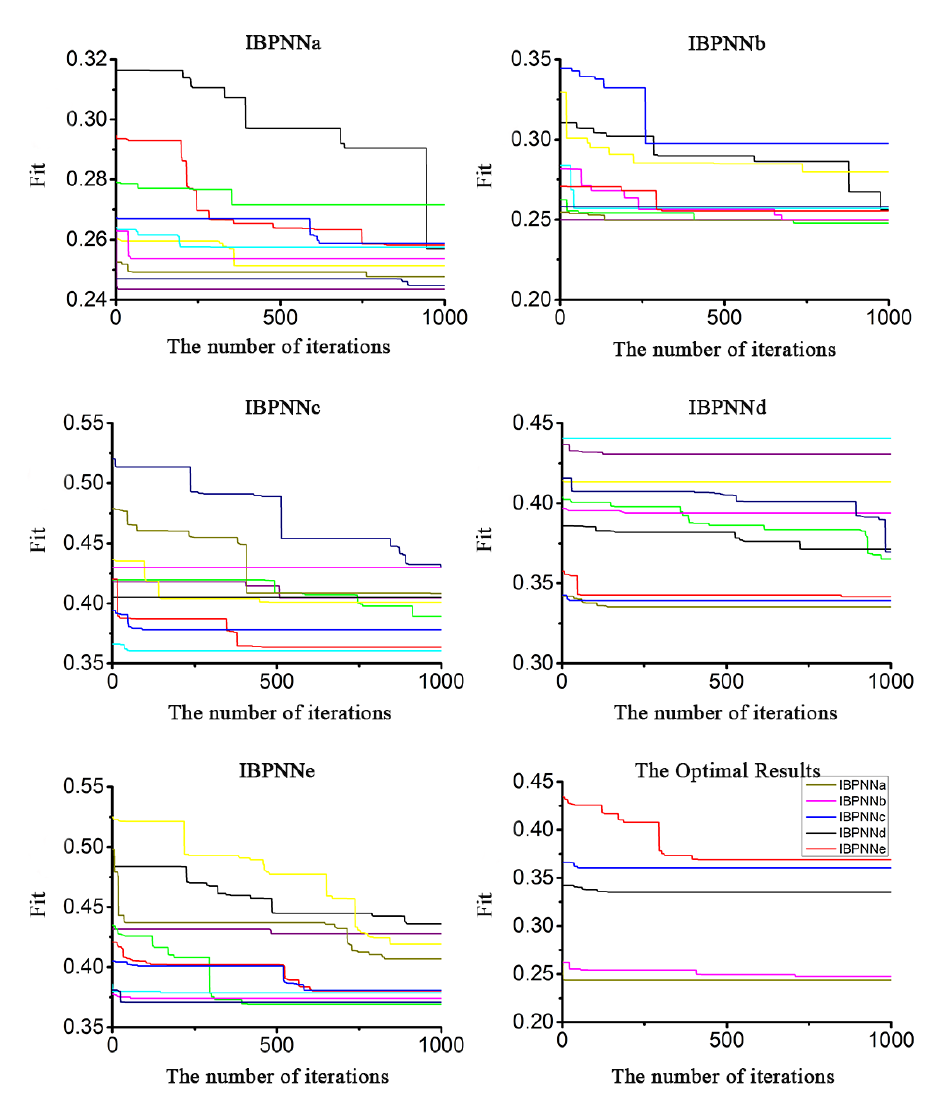
Figure 9. Initial weight and threshold value optimization with artificial bee colony (ABC) (each color represents a single global search).